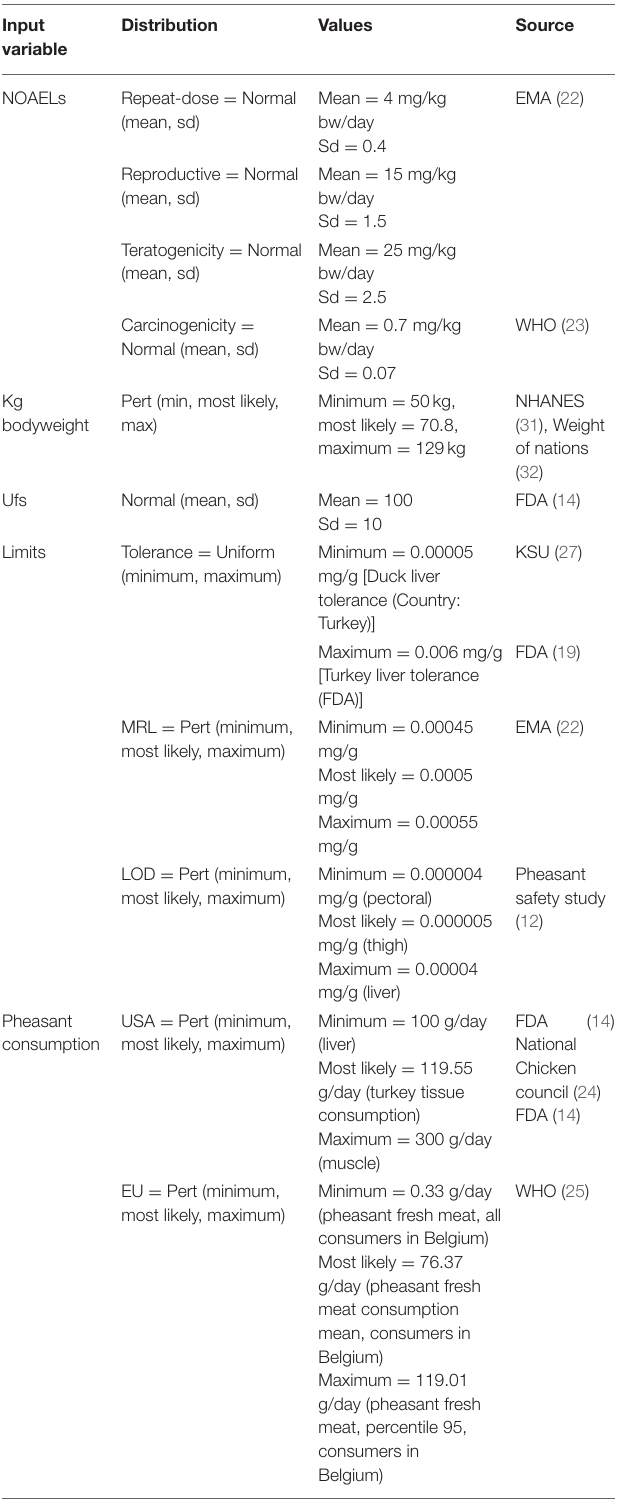
TABLE 3 | Summary of parameters used for stochastic process to perform a risk assessment for human consumption of pheasant tissues with fenbendazole sulfone